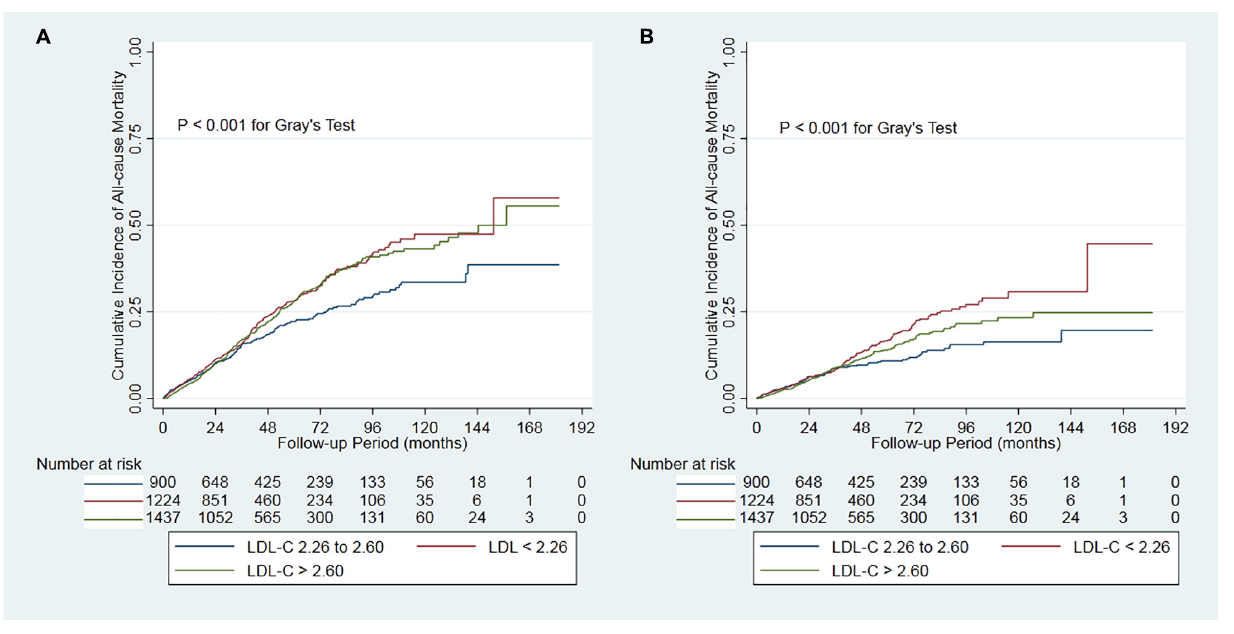
FIGURE 2 | Cumulative mortality by categories of low-density lipoprotein cholesterol. Panel (A) showed cumulative all-cause mortality by categories of LDL-C. Panel (B) showed cumulative cardiovascular mortality by categories of LDL-C. LDL-C, low-density lipoprotein